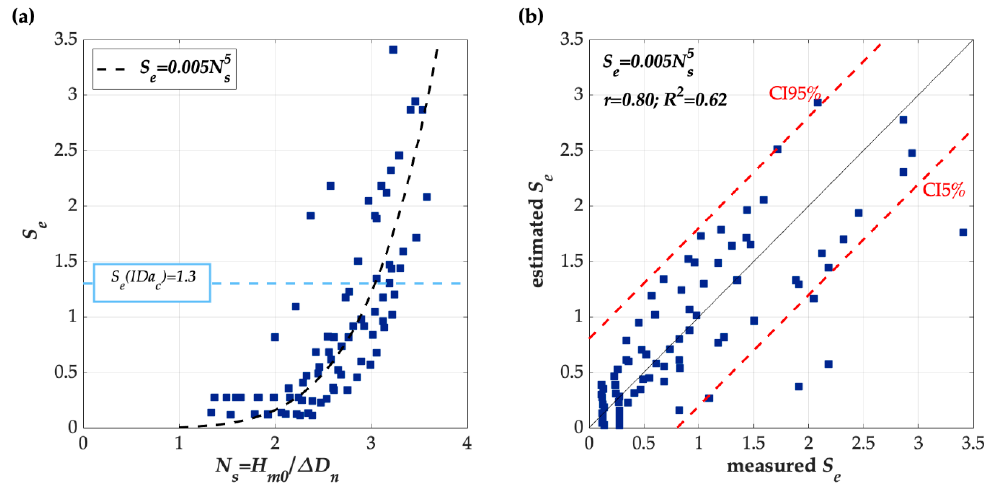
Figure 9. Performance of Equation (14) with K 1 = 0.005 and K 2 = 5 to estimate armor damage of the crest of the cube-armored model: ( a ) Fitting to the measured data and IDa level, and ( b ) measured against estimated S e . The values of K 1 = 0.005 and K 2 = 5 for Equation (14) are valid within the ranges 1.2 ≤